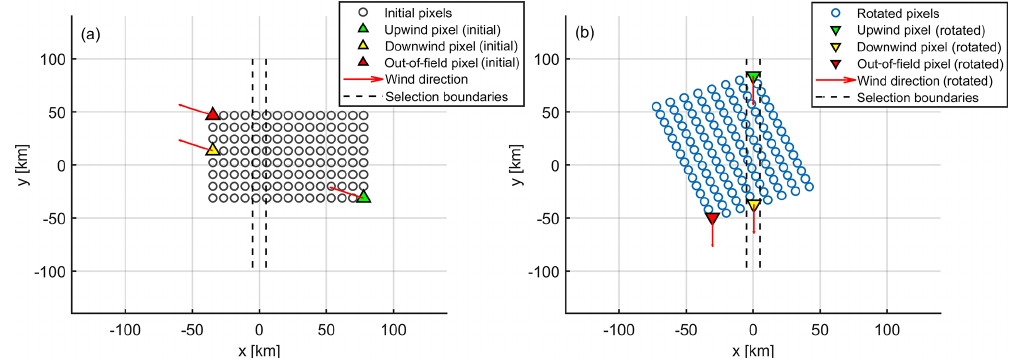
Figure 2. Visualization of the wind-based method, (a) initial positions of satellite ground pixels, and (b) rotated positions of these satellite ground pixels, both in local tangent plane coordinates. Examples of upwind (green), downwind (yellow), and out-of-field (red) pixels are shown by colour-coded triangles with wind arrows. Dashed black lines are the boundaries used to select pixels (and measurements) that are coincident with the ground-based